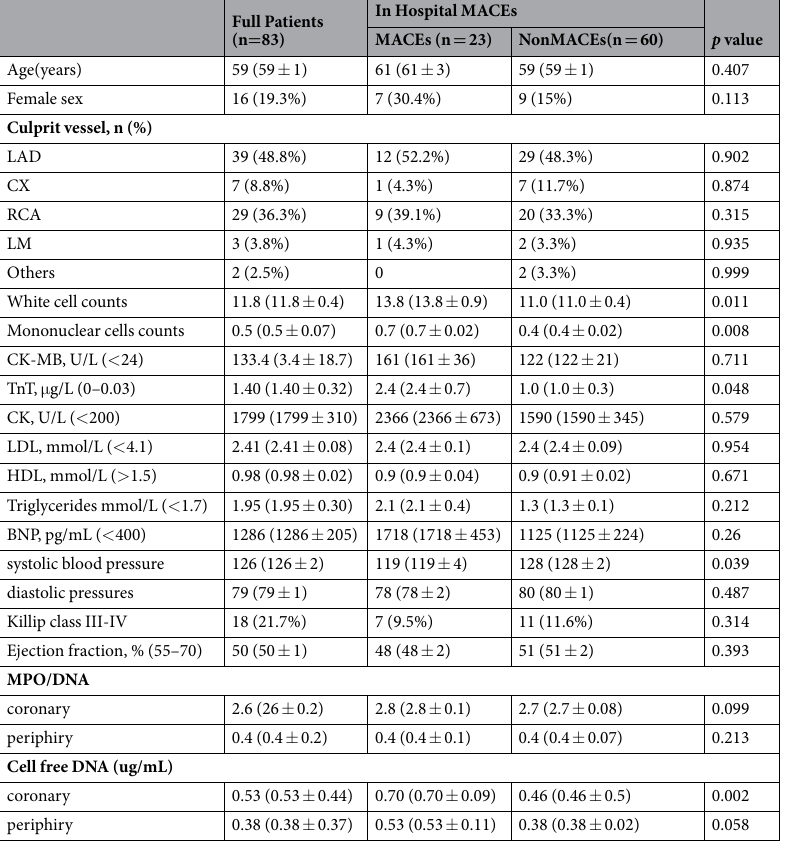
Table 3. Description of patient association of different variables with in-hospital MACEs. Data are presented as mean ± SD, or number (percent) of patients. Normal ranges are given in parenthesis. LAD, left anterior